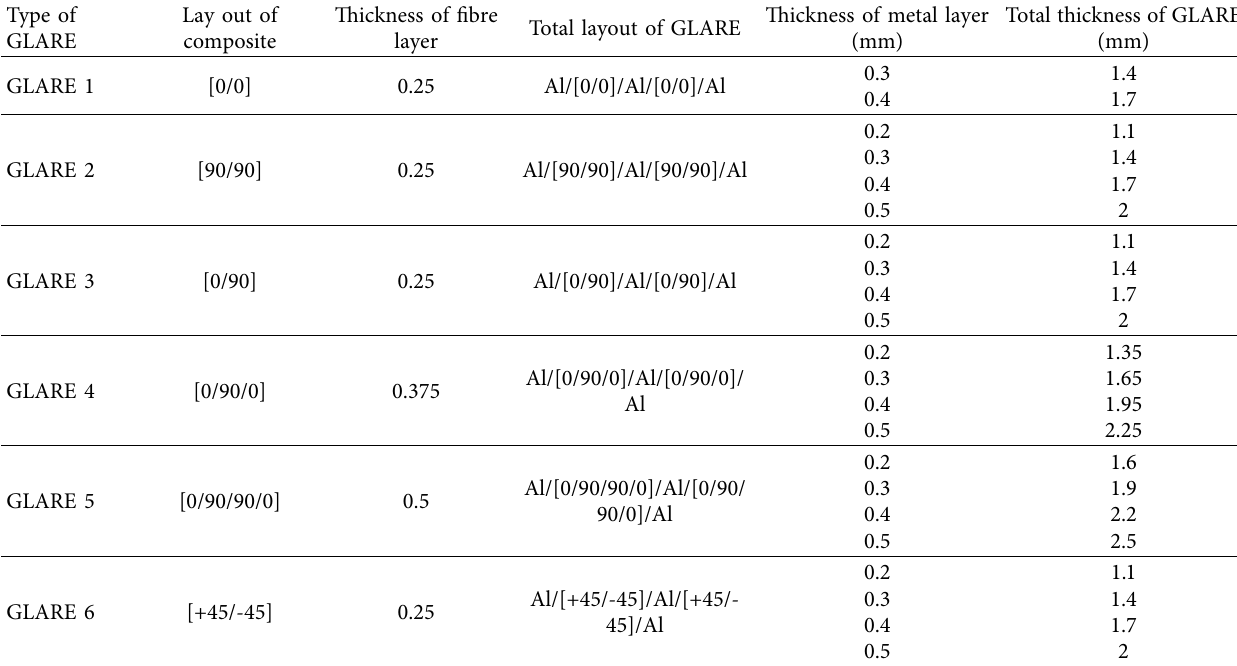
Table 2: Geometry and layout of different grades of GLARE considered in this study. Type